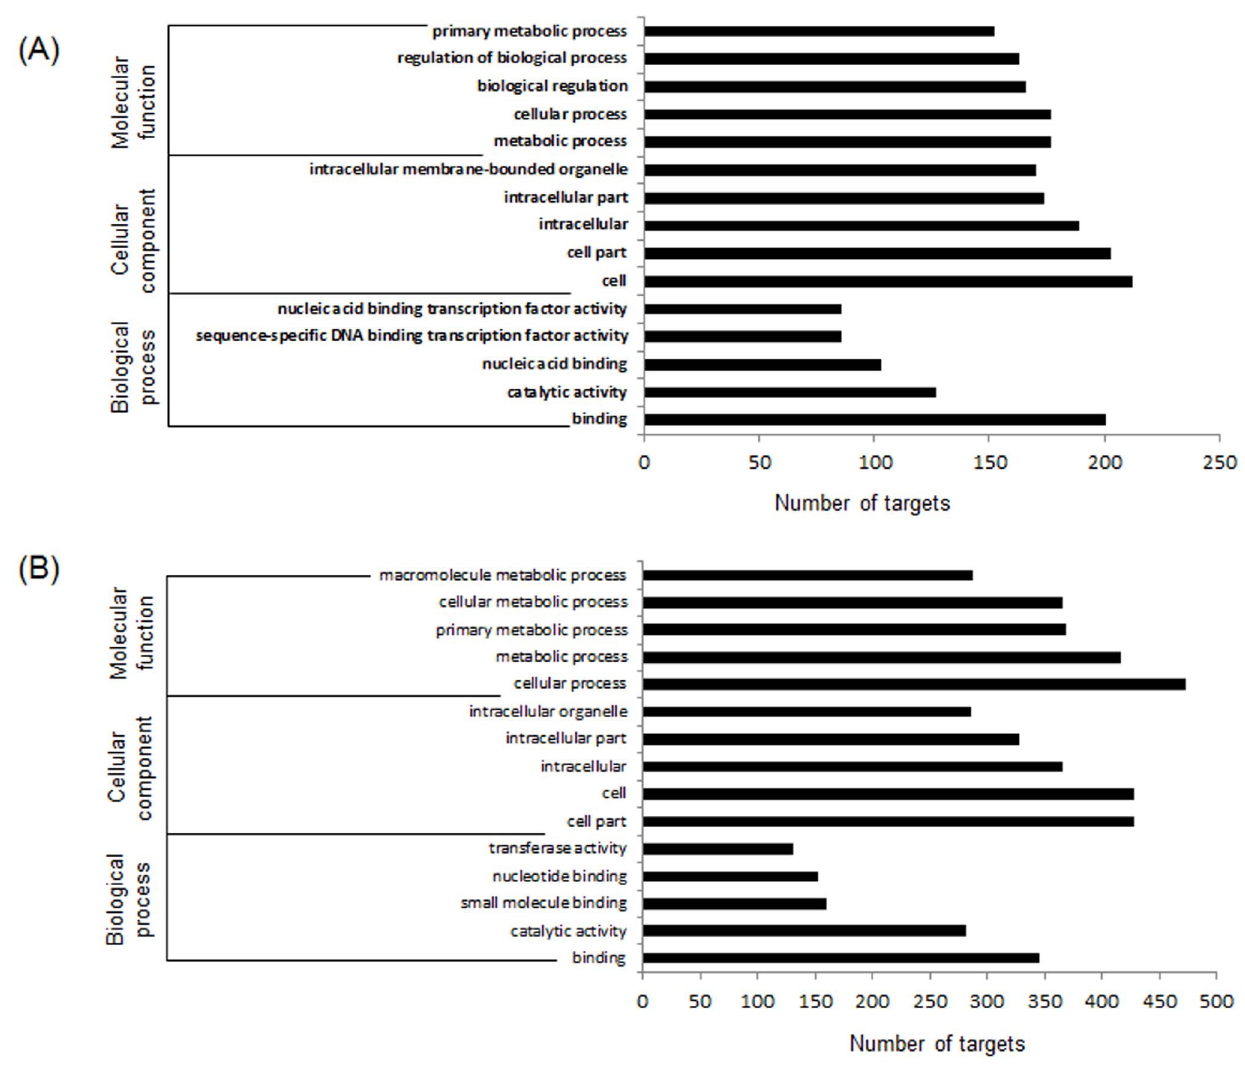
Figure 3. Gene ontology analysis of predicted targets of conserved (A) and novel (B) miRNAs. For each GO category (molecular function, cellular component and biological process) top 5 GO terms obtained through Blast2GO resource (www.blast2go.com) are presented.